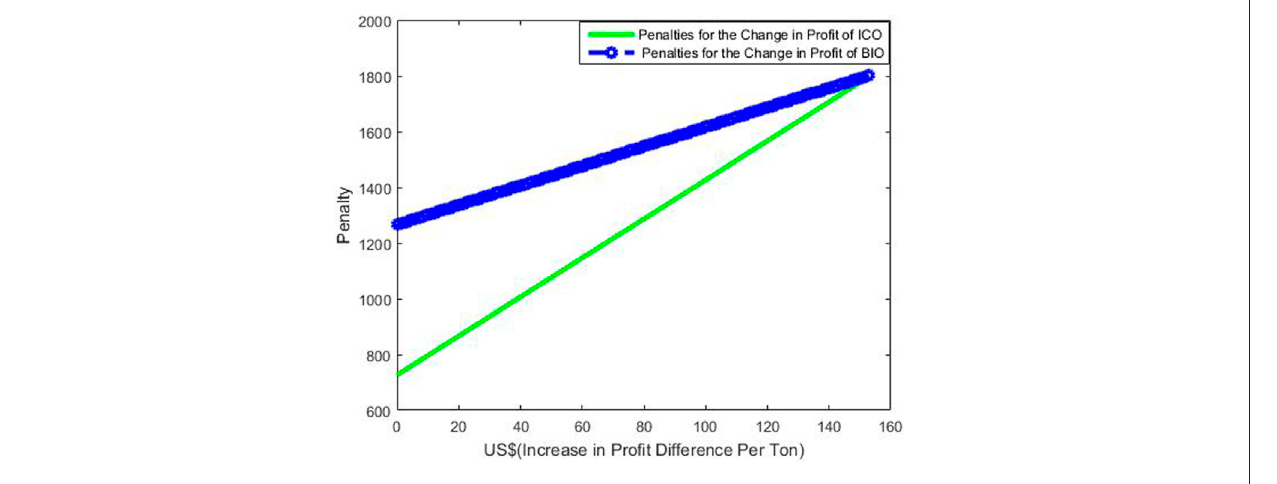
FIGURE 6 | The effect of changes in pro fi t for TFT on penalties.